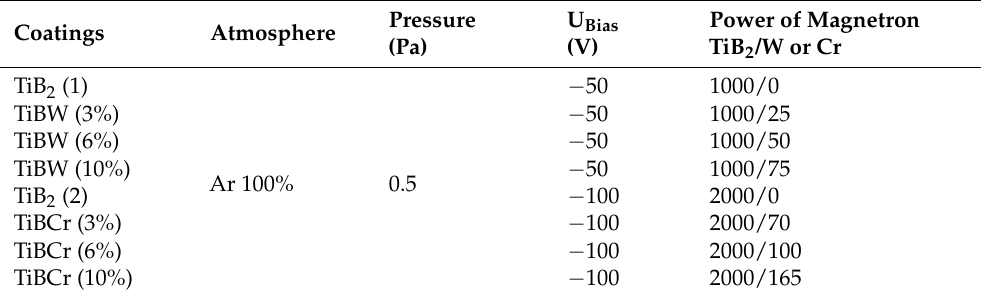
Table 1. The deposition parameters by the MS-DC methods for a series of TiBW and TiBCr coatings doped by tungsten and chromium in a concentration of 0, 3, 6 and 10 at % [20,22].